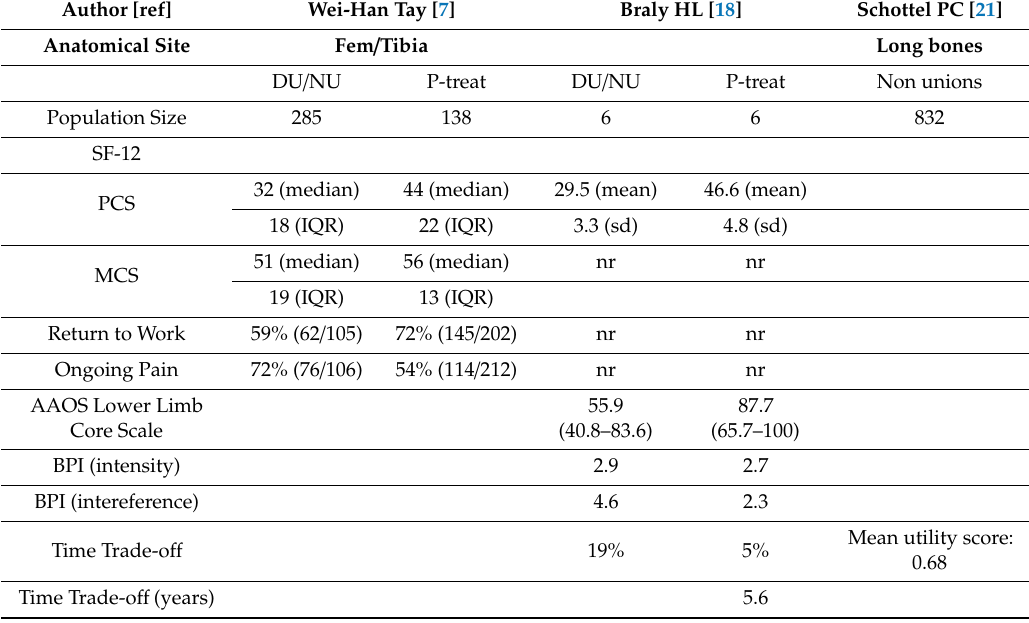
Table 4. Outcomes of the non-pooled analysis.